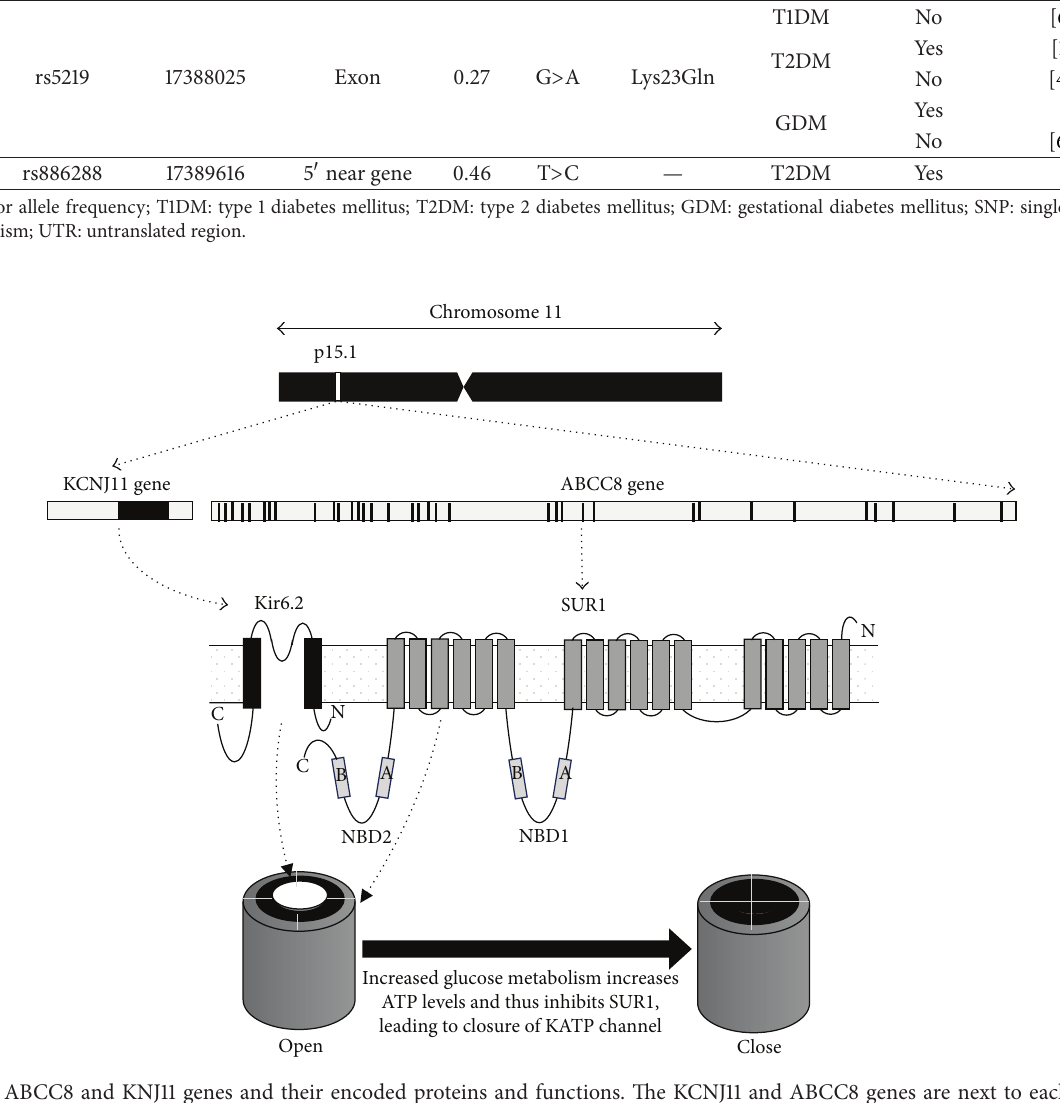
Figure 1: ABCC8 and KNJ11 genes and their encoded proteins and functions. The KCNJ11 and ABCC8 genes are next to each other on chromosome 11p15.1. KCNJ11 is a single exon (dark box) gene encoding the Kir6.2 protein, and ABCC8 has 35 exons (dark boxes) encoding the SUR1 protein; both are subunits of the ATP-sensitive potassium (KATP) channel. Metabolism of glucose can affect ATP levels and thereby the function of the KATP channel. ABCC8: ATP-binding cassette transporter subfamily C member 8; KCNJ11: potassium inwardly-rectifying channel, subfamily J, member 11; Kir6.2: inward-rectifier potassium ion channel; SUR1: sulfonylurea receptor 1; NBD1: